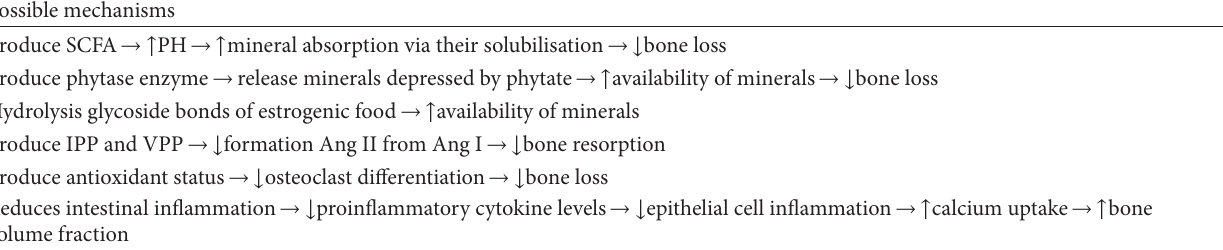
Table 2: Possible mechanisms of probiotics on